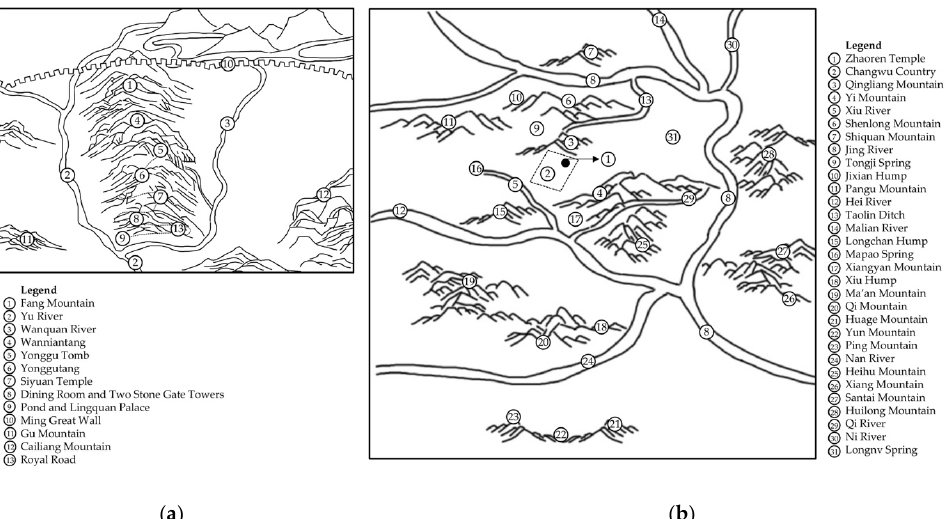
Figure 3. The two temples and surrounding mountains and rivers. ( a ) The Siyuan Temple and surrounding mountains and rivers, based on the records of The Chronicle of Changwu County ; ( b ) the mountains and rivers surrounding Zhaoren Temple, based on the records of The Chronicle of Da- tong County